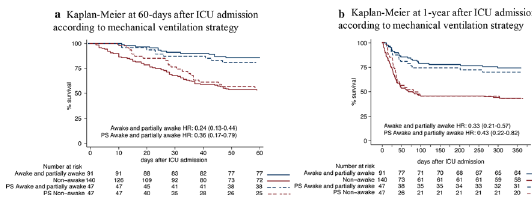
Fig. 1 Kaplan‑Meier curves at 60‑day and 1‑year according to mechani‑ cal ventilation strategy CO‑06 Impact of pulmonary hypertension on post heart